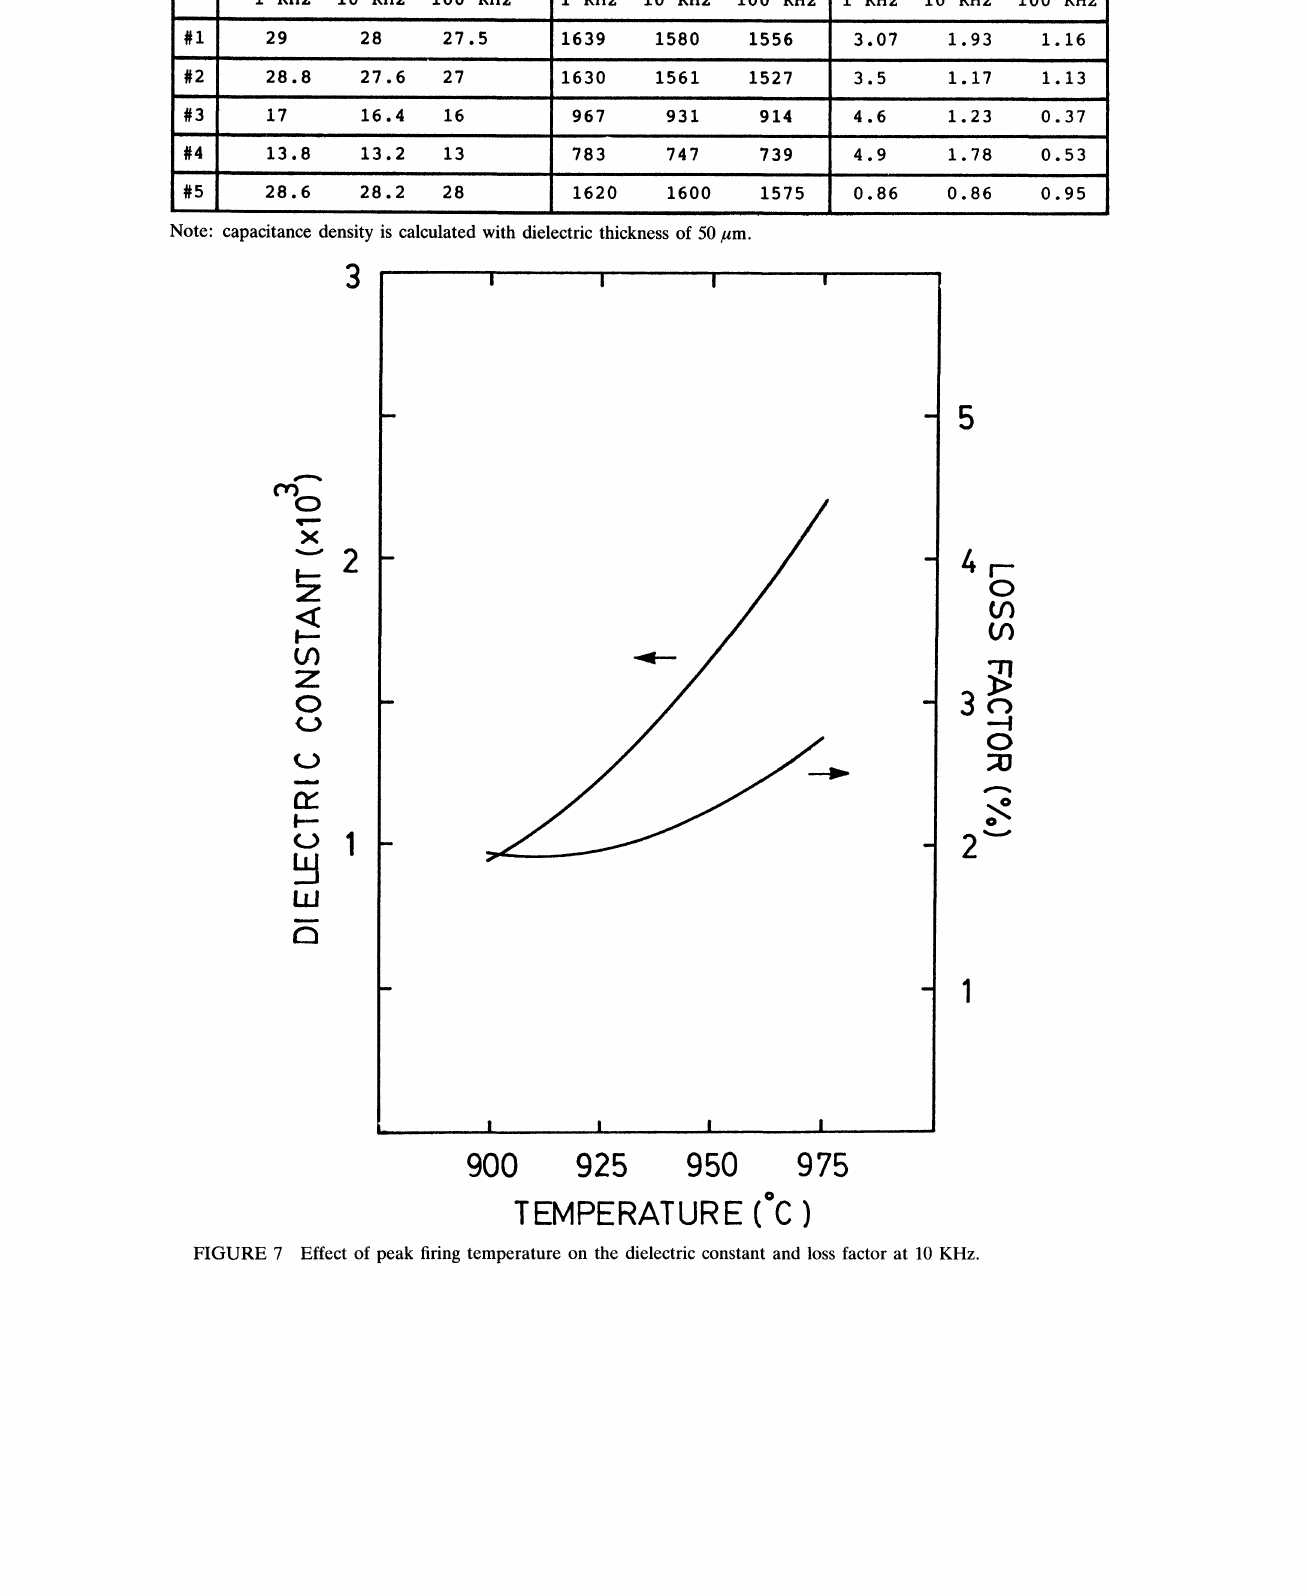
FIGURE 7 Effect of peak firing temperature on the dielectric constant and loss factor at 10